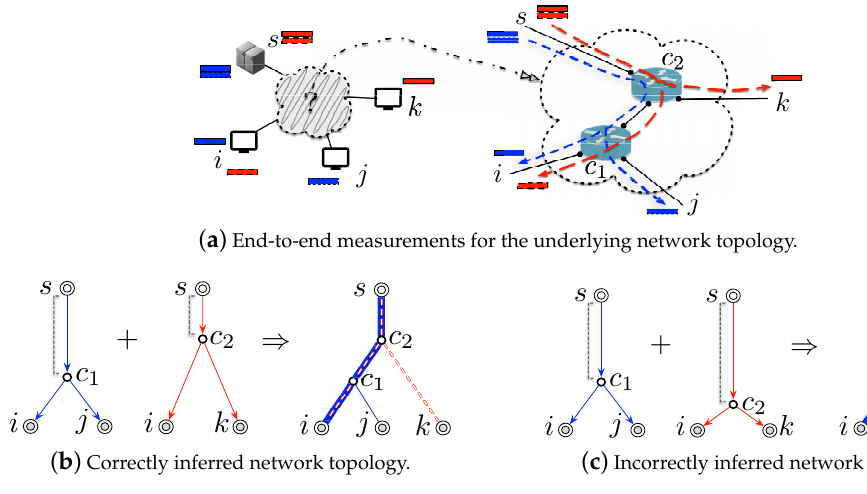
Figure 1. Illustration of network topology